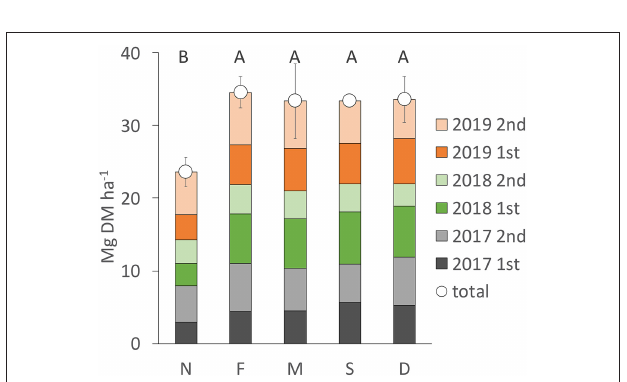
FIGURE 6 | Cumulative dry matter yield of grass. N is the no fertilizer plot, F is the chemical fertilizer plot, M is the manure plot, S is the slurry plot, and D is the digestive fluid plot. Error bars represent standard